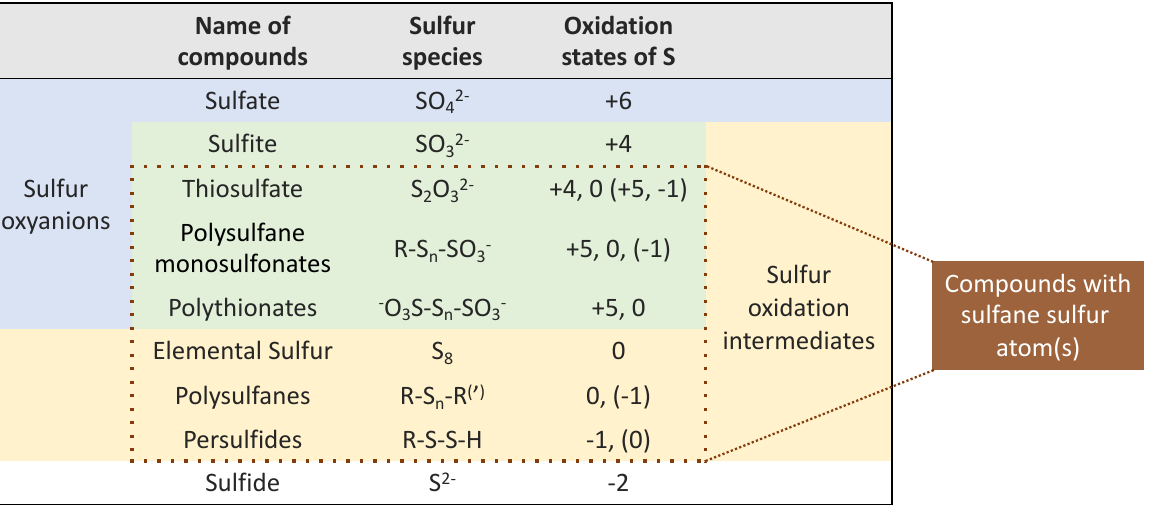
Figure 1. Selected sulfur compounds and their oxidation states (values in parentheses vary due to resonance structures of sulfur species or R